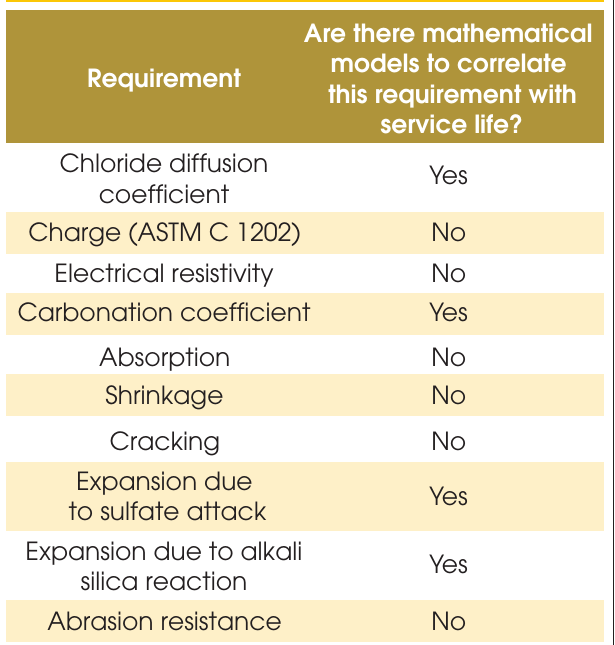
Table 3 – Mathematical models for performance requirements related to